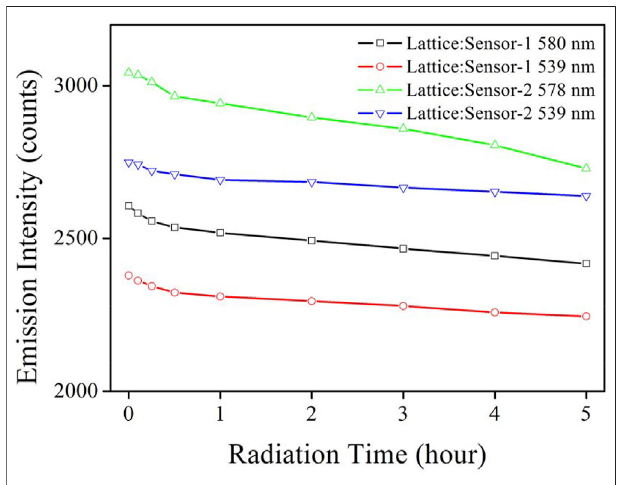
FIGURE 9 | Emission intensity monitoring of Lattice:Chemosensor systems under continuous radiation (in PBS, pH = 7.0, 5 mg in 10 ml for host, 10 μ M for chemosensors, 10 μ M for Cys, λ ex = 980